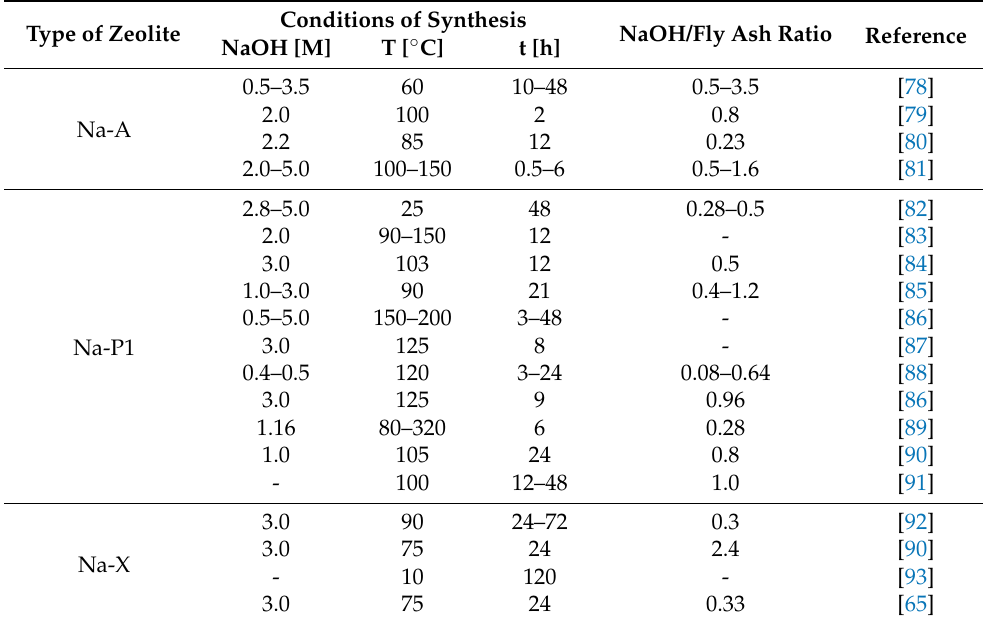
Table 2. Selected publications on the synthesis of synthetic zeolites Na-A, Na-P1, and Na-X from fly